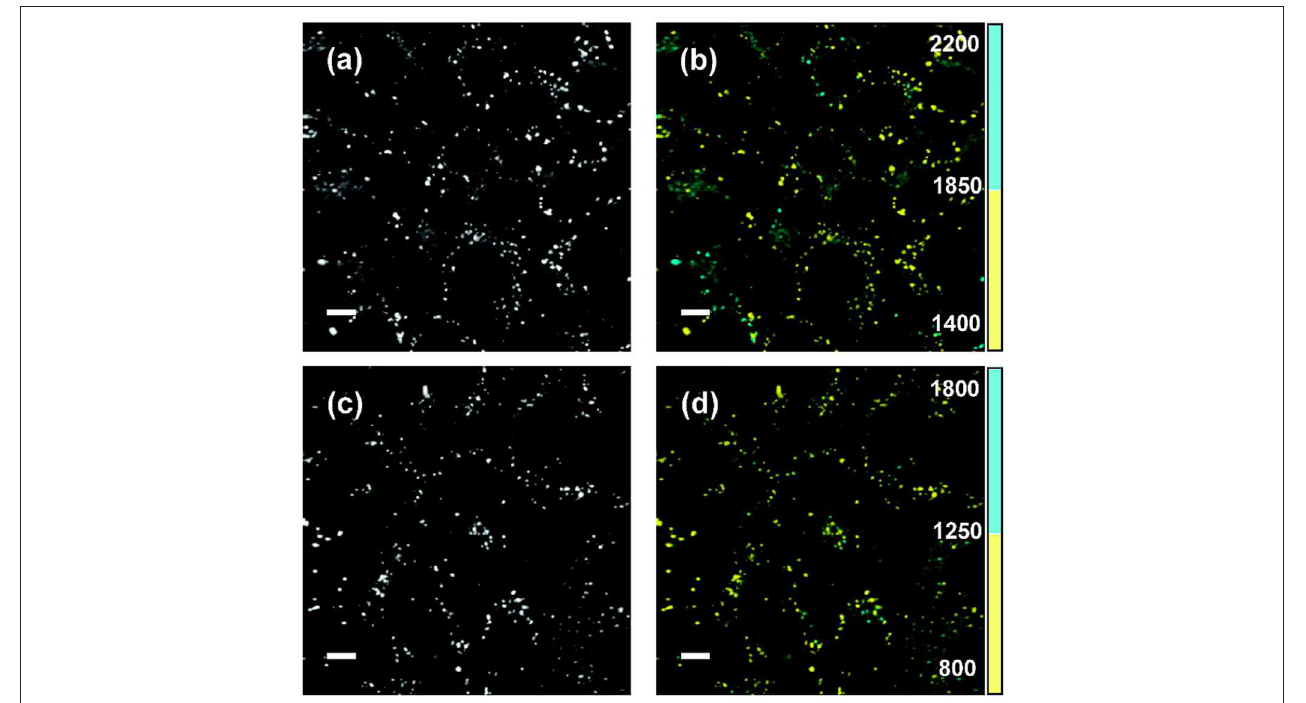
FIGURE 12 | FLIM viscosity measurement. Fluorescence intensity (a,c) and FLIM images (b,d) for live SK-OV-3 human ovarian carcinoma cells incubated with two different viscosity-sensitive dyes (bottom & top). The fluorescence lifetimes are encoded in two discrete color scales, blue for a long lifetime range, indicating a higher viscosity, and yellow for a short lifetime range, indicating a lower viscosity. The lifetime range for the fluorescent molecular rotor dyes used in (b) is 1,400–1,850 ps in yellow and 1,850–2,200 ps in blue, and for the dye used in (d) 800–1,250 ps in yellow and 1,250–1,800 ps in blue. Scale bars: 10 µ m. Reproduced from [185].